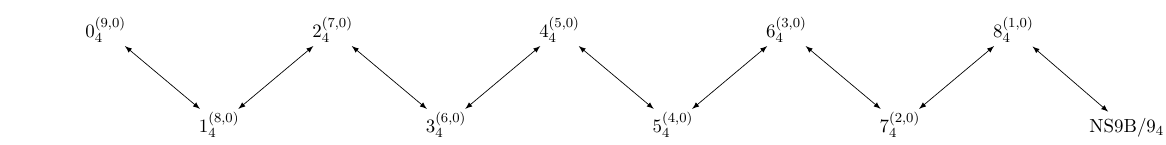
Figure 8 . T-duality orbit of the 7 (2 ; 0) . Note that this is formed from two distinct, though mirrored, 4 orbits. See the discussion in section